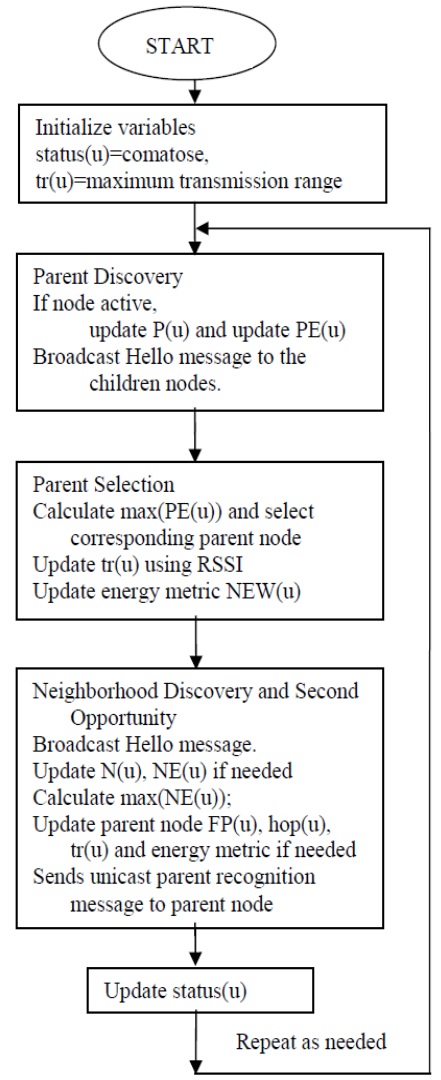
Fig. 4. EAST with neighborhood discovery topology control algorithm Fig. 5 for the SWST Protocol is based upon the detailed description about the two EAST protocol and SWST algorithms found in Refs. 1.-3. The simulations and results are shown in the next